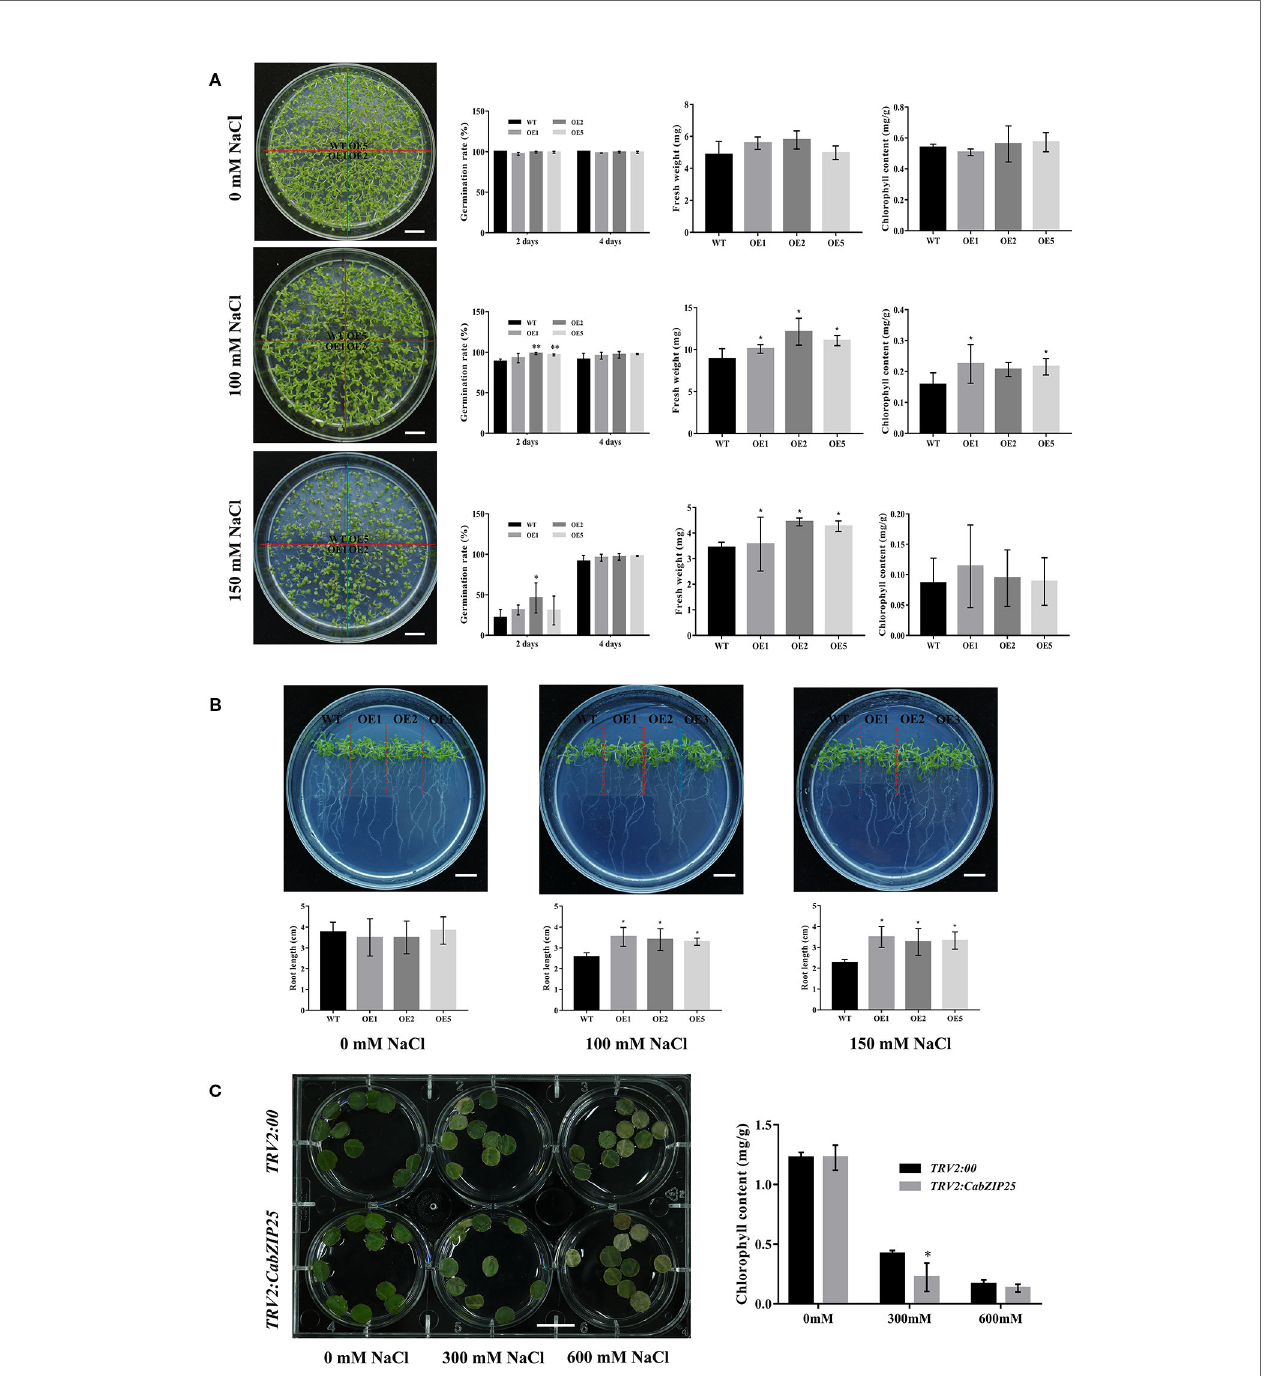
FIGURE 6 | Function analysis of CabZIP25 under salt stress. (A) Phenotypic analysis, seed germination rate, fresh weight, and chlorophyll content of Arabidopsis treated with different concentrations of NaCl for 10 days. (B) The phenotype and length of Arabidopsis roots at 10 days after different concentrations of NaCl. (C) The phenotype and chlorophyll content of leaf discs from TRV2: 00 or TRV2: CabZIP25 plants. Error bars represent SDs for three replicates. Data are shown as means ± SD. * P < 0.05, ** P < 0.01 by Student's t -test. Bars = 1